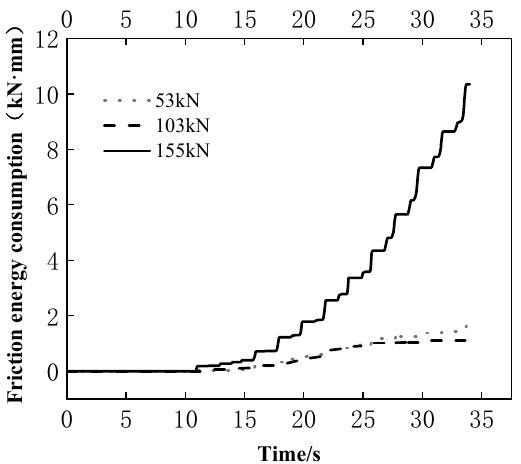
Figure 16. Friction energy dissipation curve under different prestress.